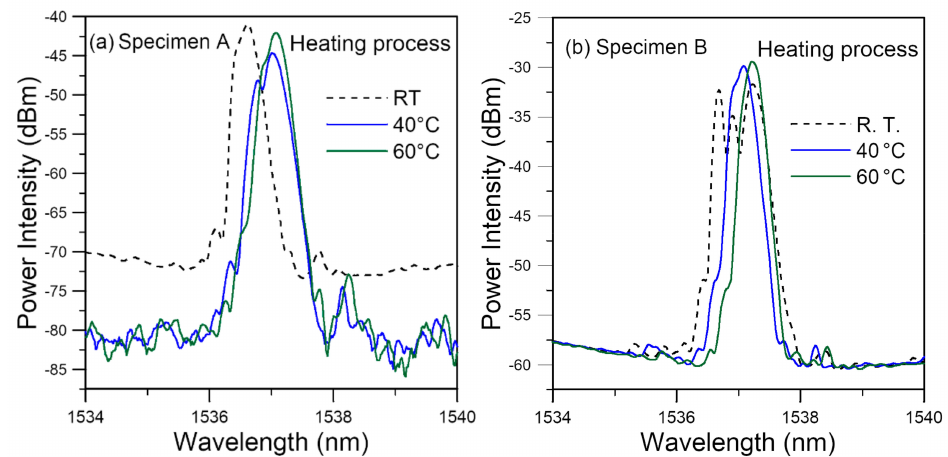
Figure 4. Embedded FBG spectra evolution during the heating process before soaking showing general shift to the right and ( a ) changing of emerging peaks and ( b ) merging of split